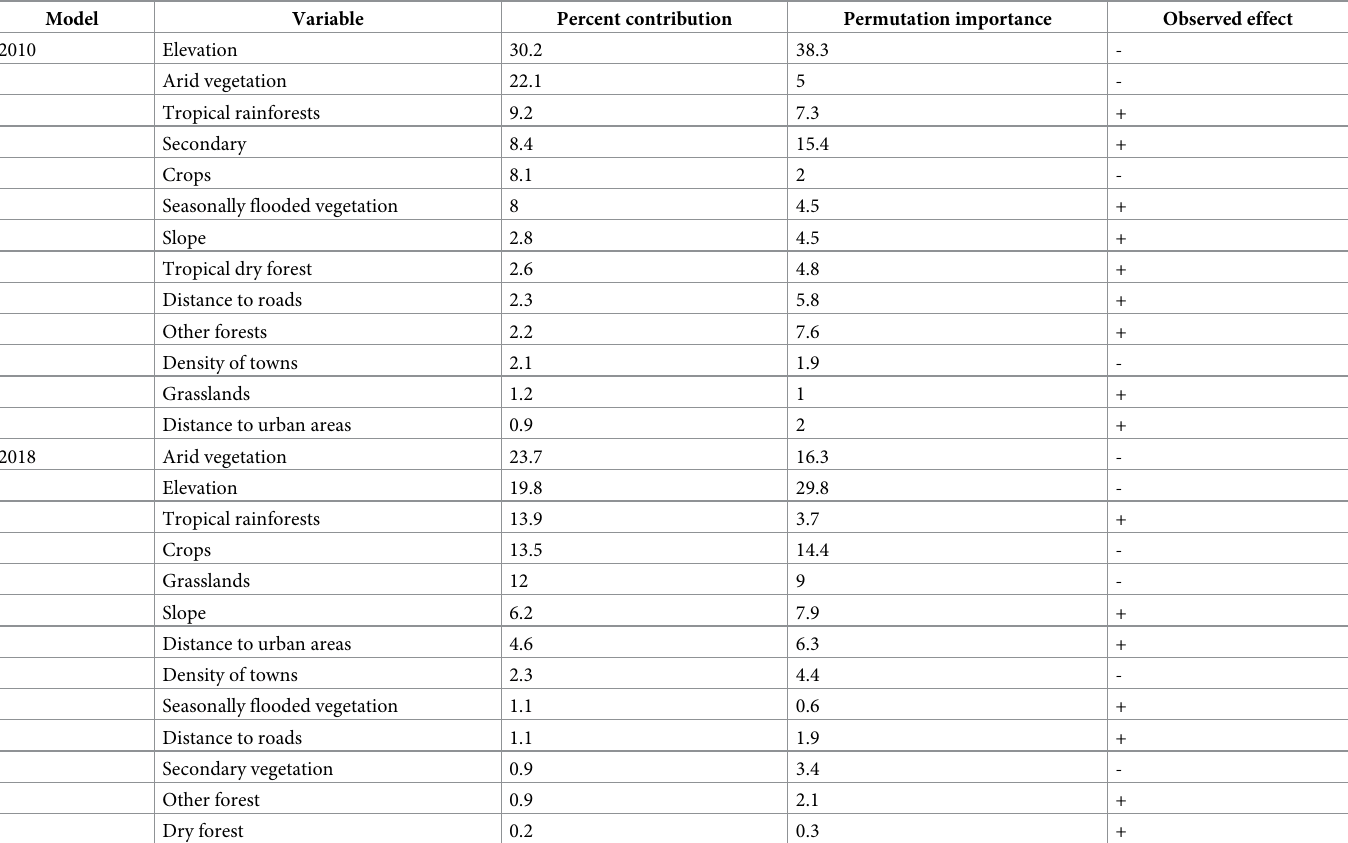
Table 3. Variable contribution to the habitat suitability models for jaguars in Mexico, as used in